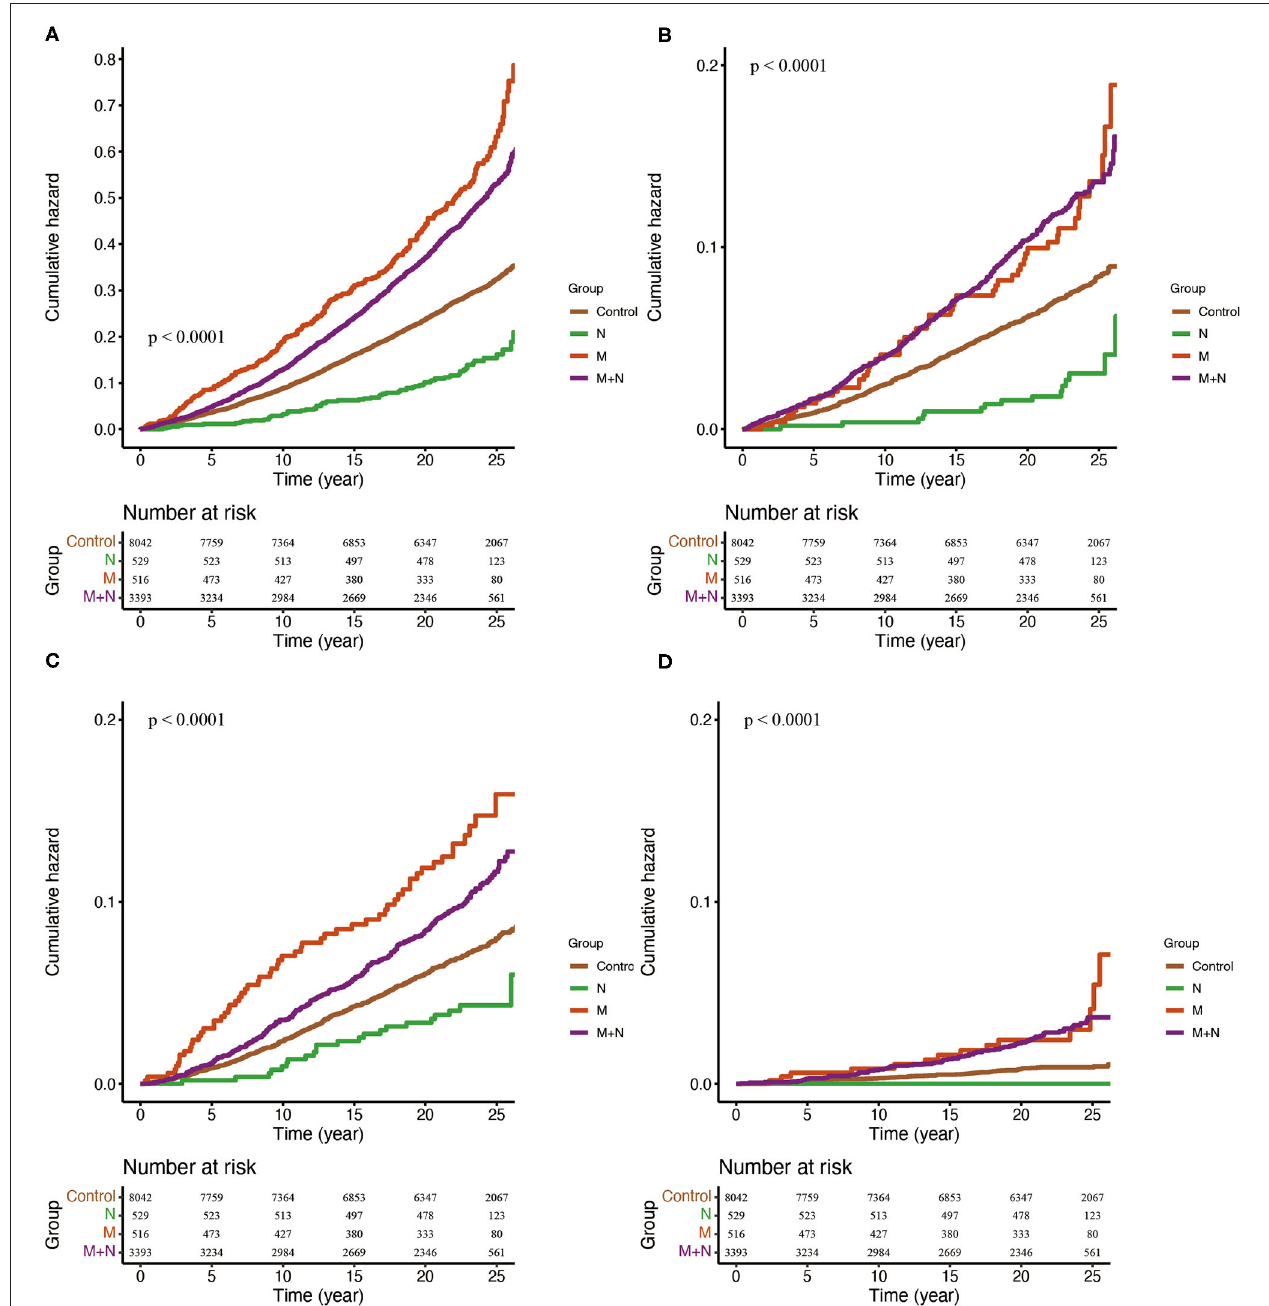
FIGURE 2 | Kaplan-Meier estimates of overall (A) , cardiovascular (B) , neoplasm (C) and diabetes-related (D) mortality. Control, participants without MAFLD or NAFLD. N, participants only with NAFLD; M, participants only with MAFLD; M + N, participants with MAFLD and NAFLD.